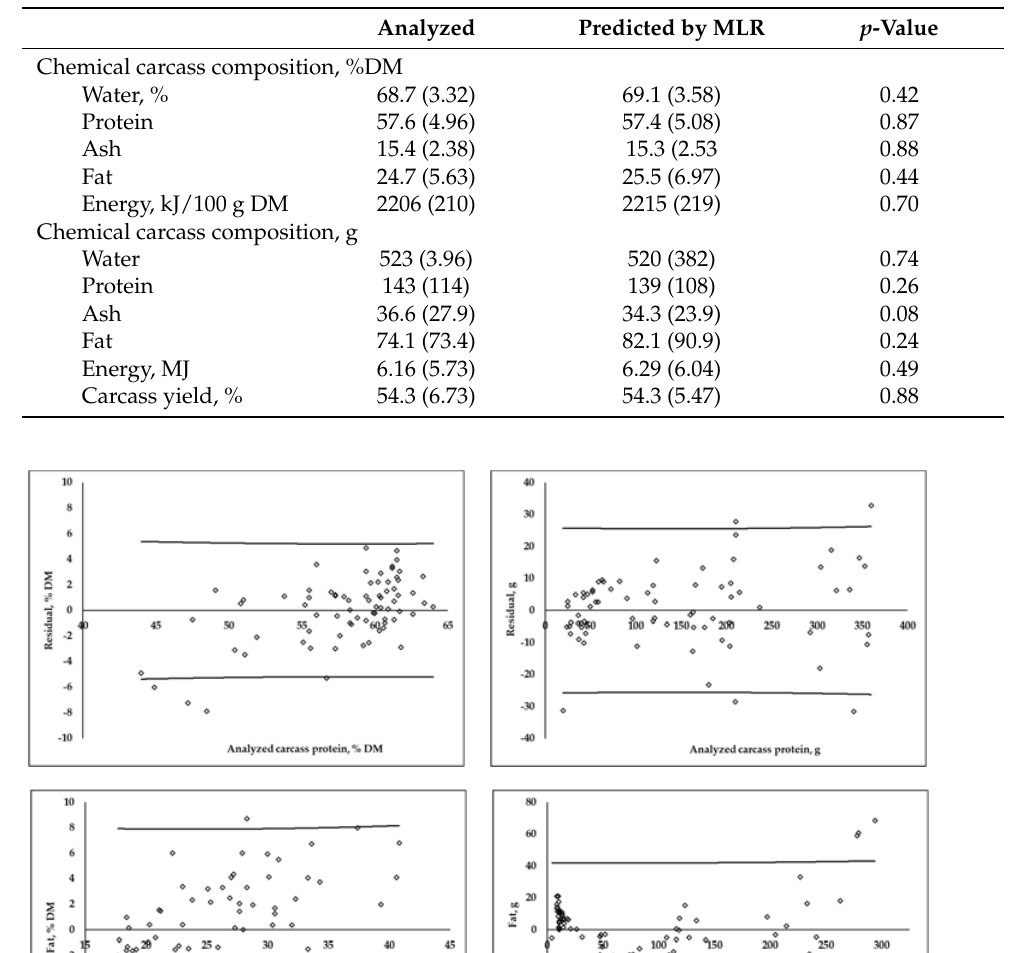
Table 7. Comparison between analyzed and predicted nitrogen, fat and energy retention and Ni ‐ trogen Retention Efficiency (NRE) and Energy Retention Efficiency (ERE) in rabbits from 35 to 63 d of age ( n = 20).